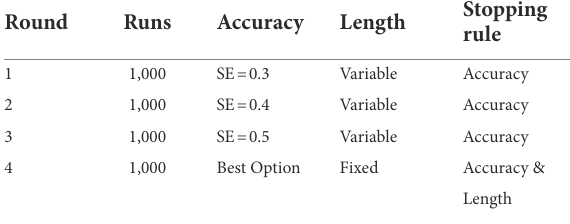
TABLE 2 Simulation rounds for each SinnL-CAT and ZasM-CAT for each 1,000 replications.